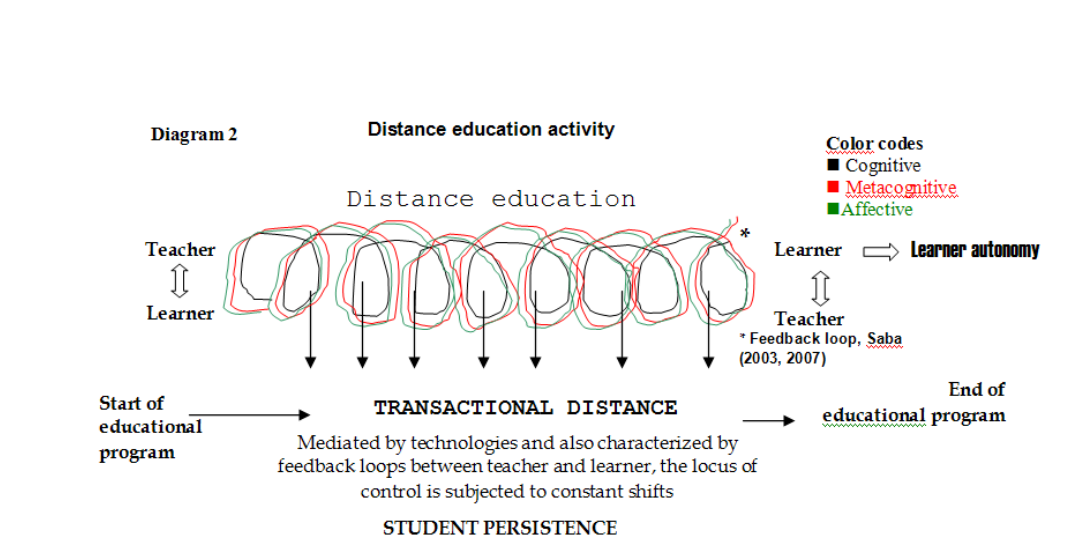
Figure 2. Distance education